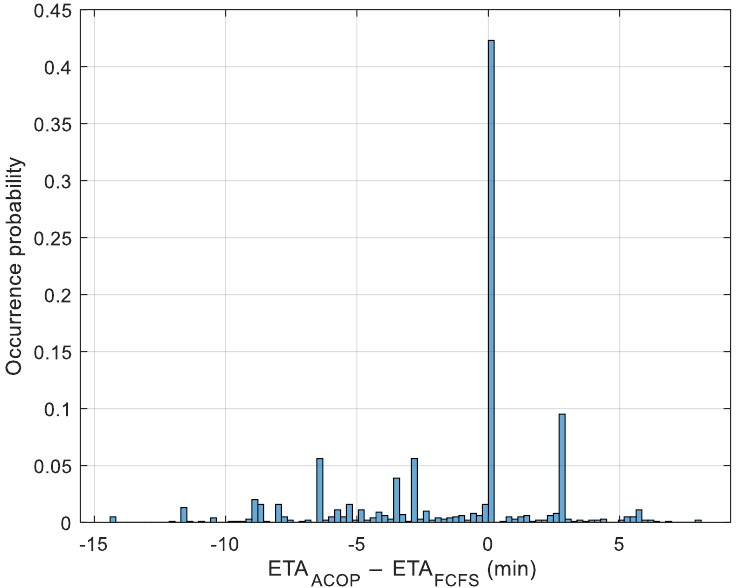
Figure 11 . ACOP fl ight time reductions. Figure 11 . ACOP flight time reductions. Figure 11. ACOP flight time reductions.